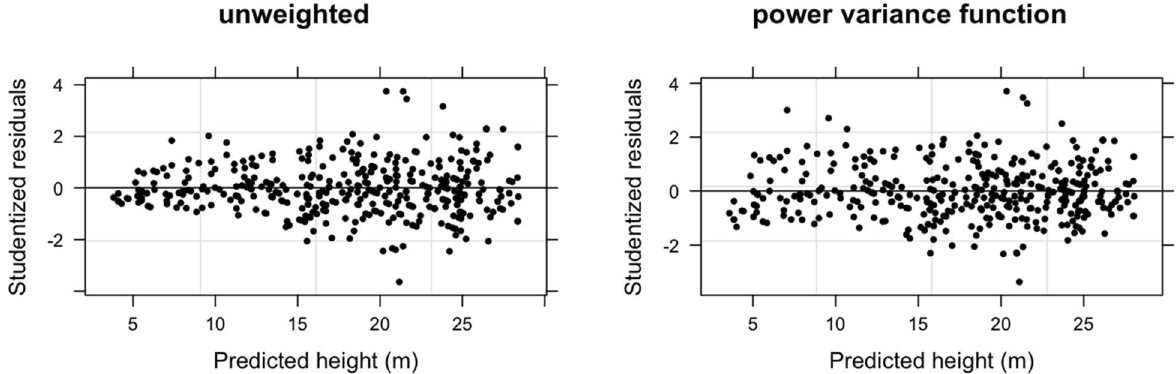
Fig. 13 The plot of studentized residuals against the predicted height for A. araucana . The studentized residuals were obtained by fitting the generalized NLME H–D model for AA without weighting (left) and with power variance function